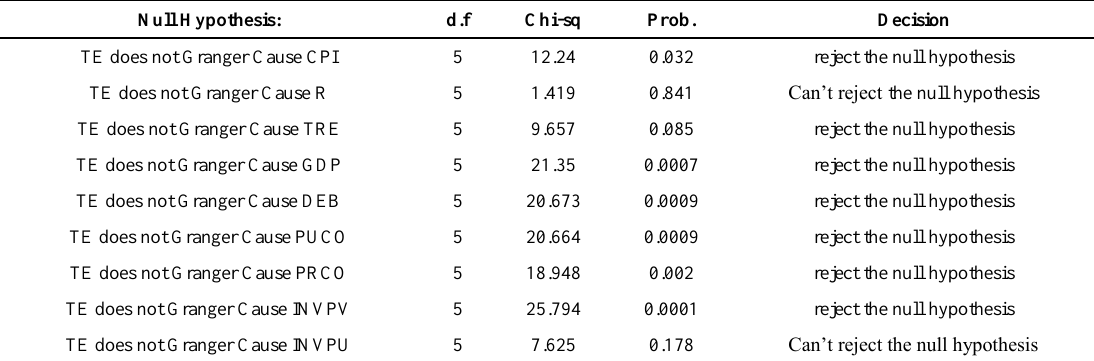
Table 8. Toda and Yamamoto Causality